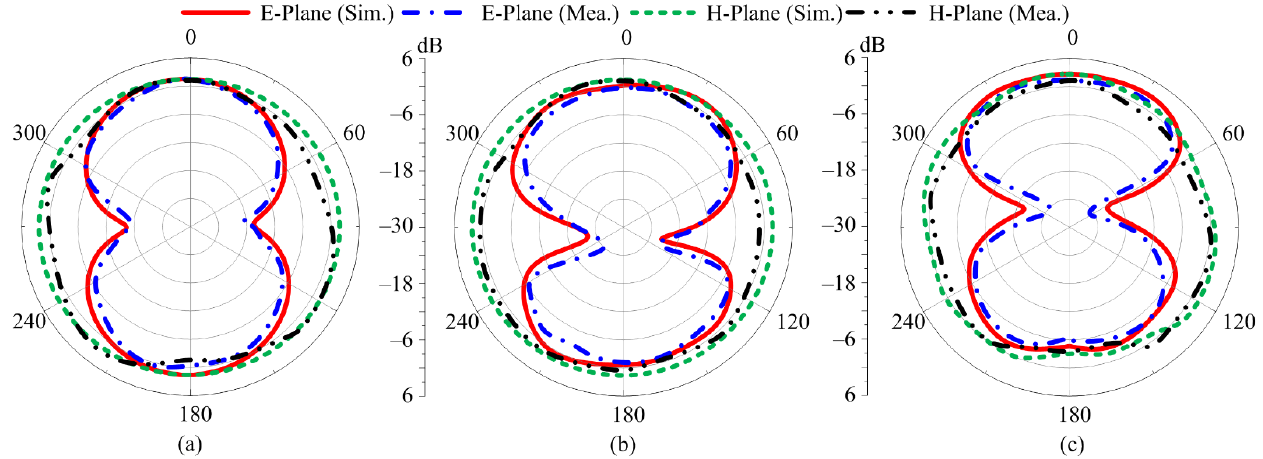
Figure 11. Comparison between simulated and measured radiation patterns for case ‐ 01 at the frequencies of ( a ) 2.8 GHz, ( b ) 4.2 GHz, and ( c ) 7 GHz.